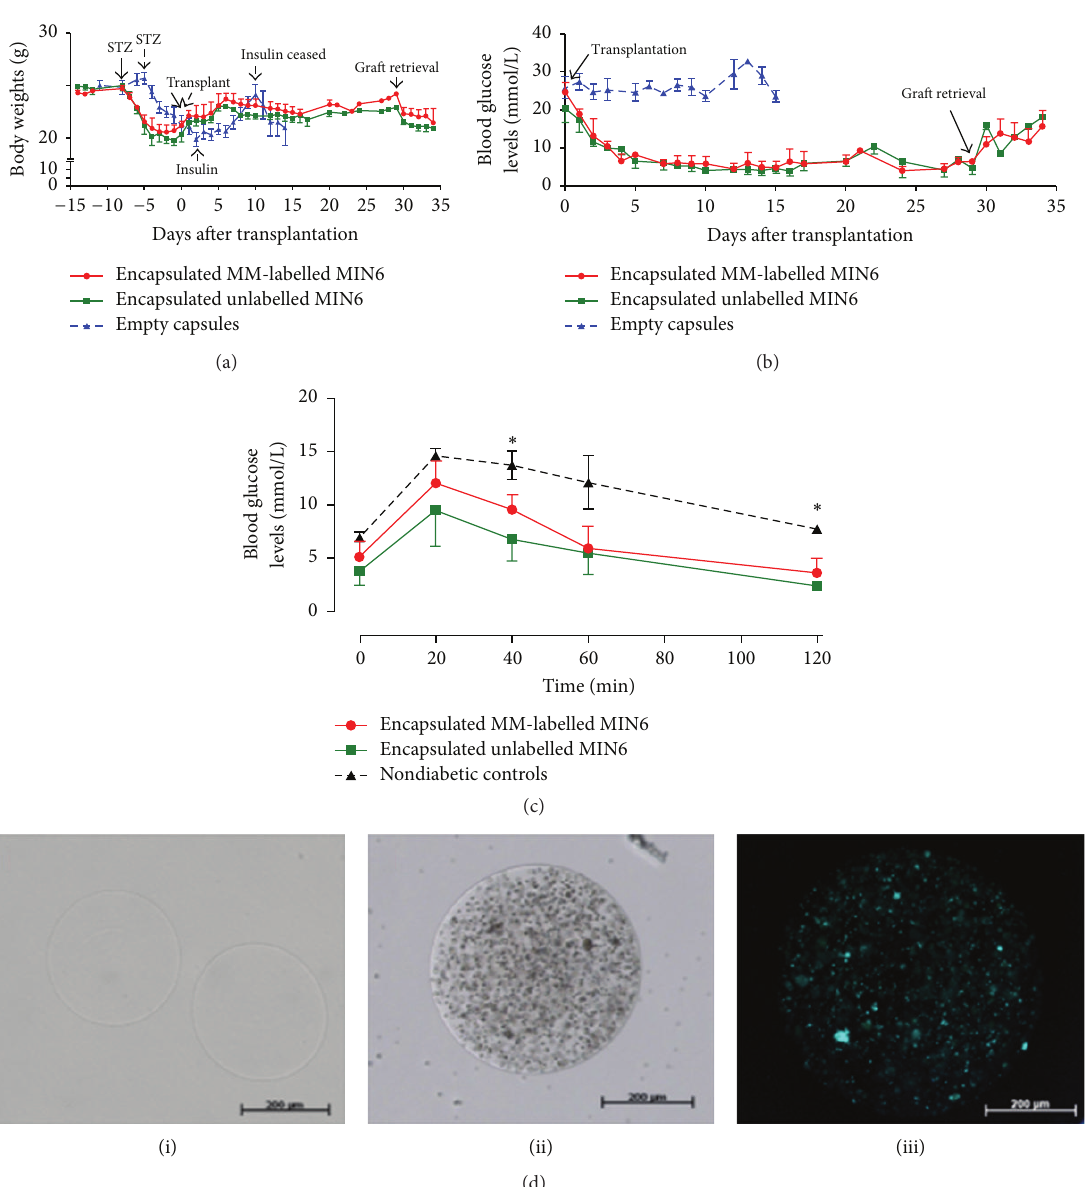
Figure 4: Transplantation of encapsulated MM-labelled MIN6 cells. Diabetic mice were transplanted with either encapsulated MM-labelled or unlabelled MIN6 (1.5 × 10 6 cells/mouse) into the peritoneal cavity and monitored for up to 30 days after transplantation. (a) Body weights (g) of animals transplanted with either encapsulated MM-labelled or unlabelled MIN6 cells and empty microcapsules. Values are mean ± SEM ( 𝑛 = 4 in each group). Broken arrows denote the group transplanted with empty microcapsules. (b) Blood glucose levels (BGL) of mice transplanted with either encapsulated MM-labelled or unlabelled MIN6 cells and empty microcapsules. Normoglycemia was achieved in 100% of mice receiving both encapsulated MM-labelled and unlabelled MIN6 cells. Values are mean ± SEM ( 𝑛 = 4 in each group). (c) OGTT done at day 16 after transplantation after normalization of BGL. Values are mean ± SEM ( 𝑛 = 3 for encapsulated MM-labelled and unlabelled MIN6 and 𝑛 = 4 for nondiabetic controls); ∗ 𝑝 < 0.05 at 40 and 120 min, respectively, at 40 min nondiabetic control > encapsulated unlabelled MIN6 and at 120min nondiabetic control > encapsulated MM-labelled and unlabelled MIN6 (one-way ANOVA with post hoc Tukey-Kramer Multiple Comparison test). (d) Graft retrieval from mice transplanted with empty microcapsules at day 15 (i) and encapsulated MM-labelled MIN6 at day 29 (ii). Fluorescently labelled MM can still be detected on retrieved grafts at day 29 after transplantation (iii). Bar is 200 𝜇 m for (i), (ii), and (iii),